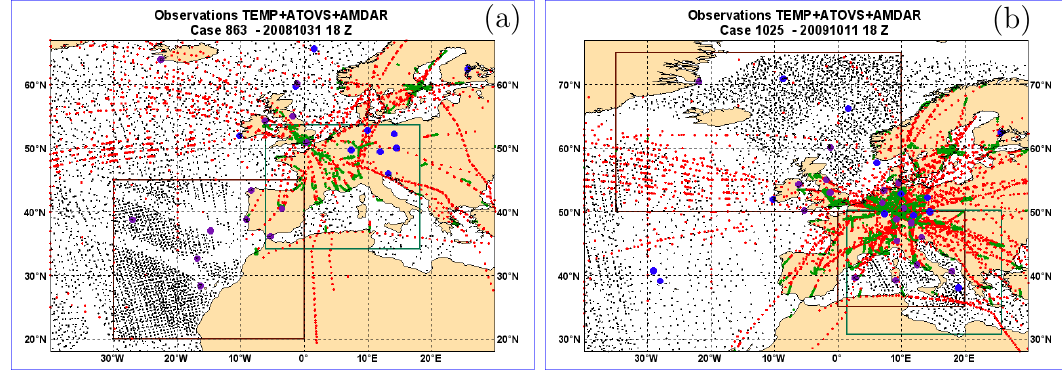
Fig. 4. Different data assimilated for case 863 (a) and for case 1025 (b) . ATOVS data are displayed in black points, AMDAR cruise altitude (above 400hPa) in red points, AMDAR profiles (below 400hPa) in light green points, operational radiosondes in blue circles, and additional radiosondes in purple circles. The verification area is marked with a green rectangle and the brown rectangles mark the targeted area used for enhanced ATOVS